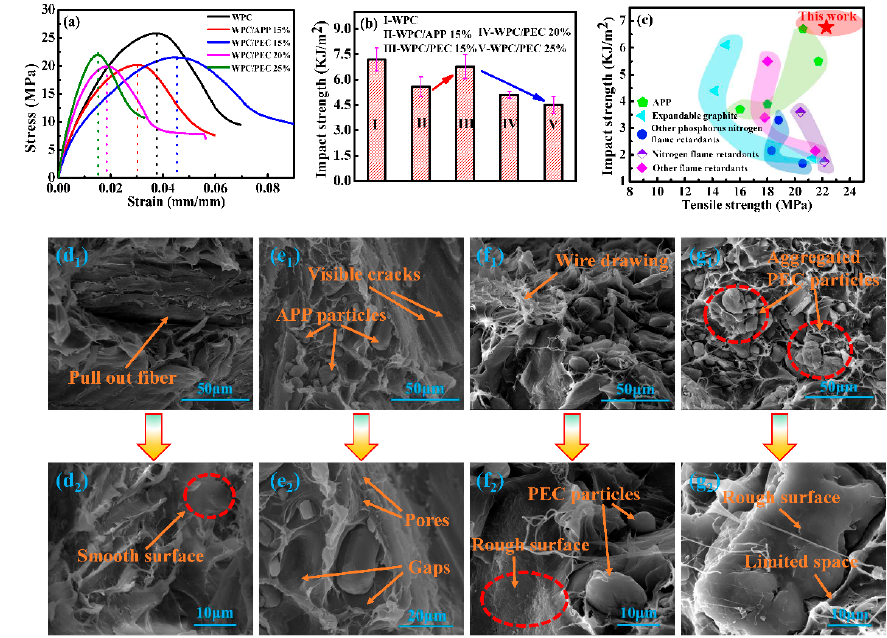
Figure 7. Mechanical properties and fractural morphology of WPC with APP and PEC: ( a ) Strain–stress curves, ( b ) impact strength, and ( c ) comparison with other reported flame retardants [2,26–32]. SEM images of WPC ( d 1 , d 2 ), WPC/APP 15% ( e 1 , e 2 ), WPC/PEC 15% ( f 1 , f 2 ), and WPC/PEC 25% ( g 1 , g 2 ).